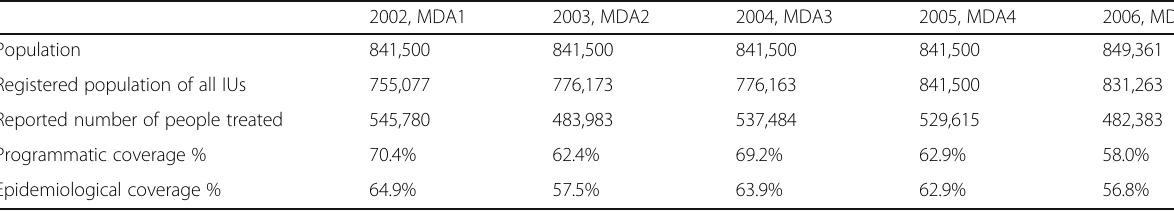
Table 3 Programmatic MDA coverage in Fiji by